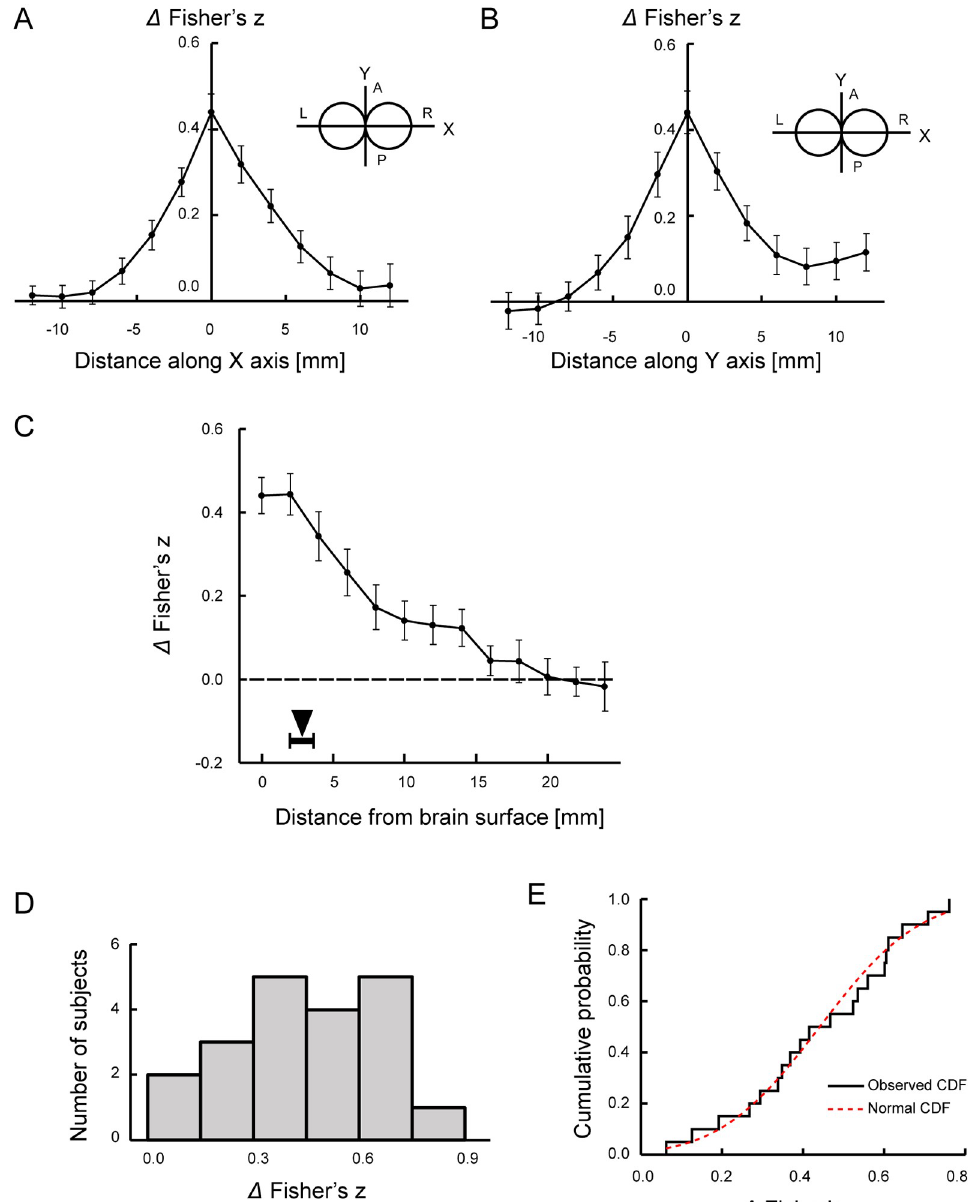
Fig 6. Cluster of connectivity changes in the surface and depth directions. (A) The differential Fisher’s z plotted along the long axis (X) in the brain surface. Vertical error bars indicate the SEM of the z values. (B) The differential Fisher’s z plotted along the short axis (Y) in the brain surface. (C) The differential Fisher’s z plotted along the stimulation vector (Z) from the brain surface. Data in white matter voxels were excluded from group averaging. The black triangle indicates the mean depth of the activation peak in M1, and the horizontal error bar indicates the SEM of the depth of the activation peaks. (D) Distribution of differential Fisher’s z in the subjects at the origin (X = 0, Y = 0, Z = 0) of the connectivity cluster. (E) Cumulative distribution function of the differential Fisher’s z of the subjects (shown in black). A red curve indicates the case of a normal distribution.